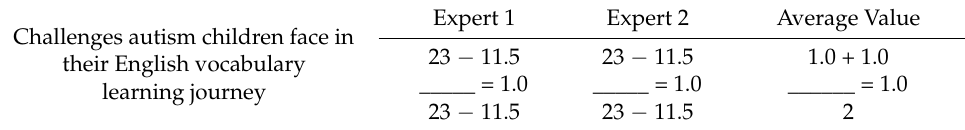
Table 3. The average value of Cohen Kappa for the challenges.